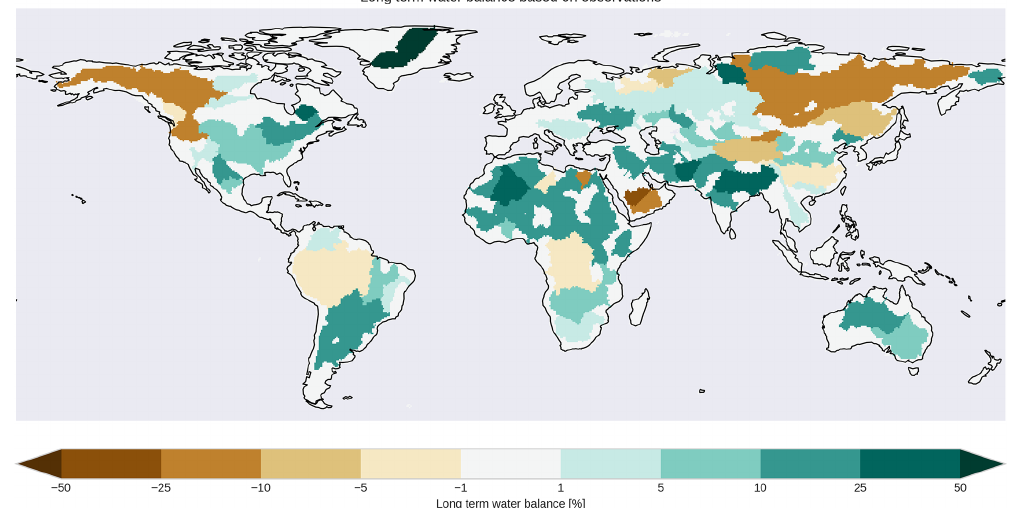
Figure 9. Long-term water balance based on GSWP3 precipitation, GLEAM evaporation and GRDC river discharge remapped to catchment scale. Note that this water balance is only a first-order estimate. No trends in storage content are included. Furthermore, the GRDC river discharge climatologies often represent different time periods than GSPW3 and GLEAM.